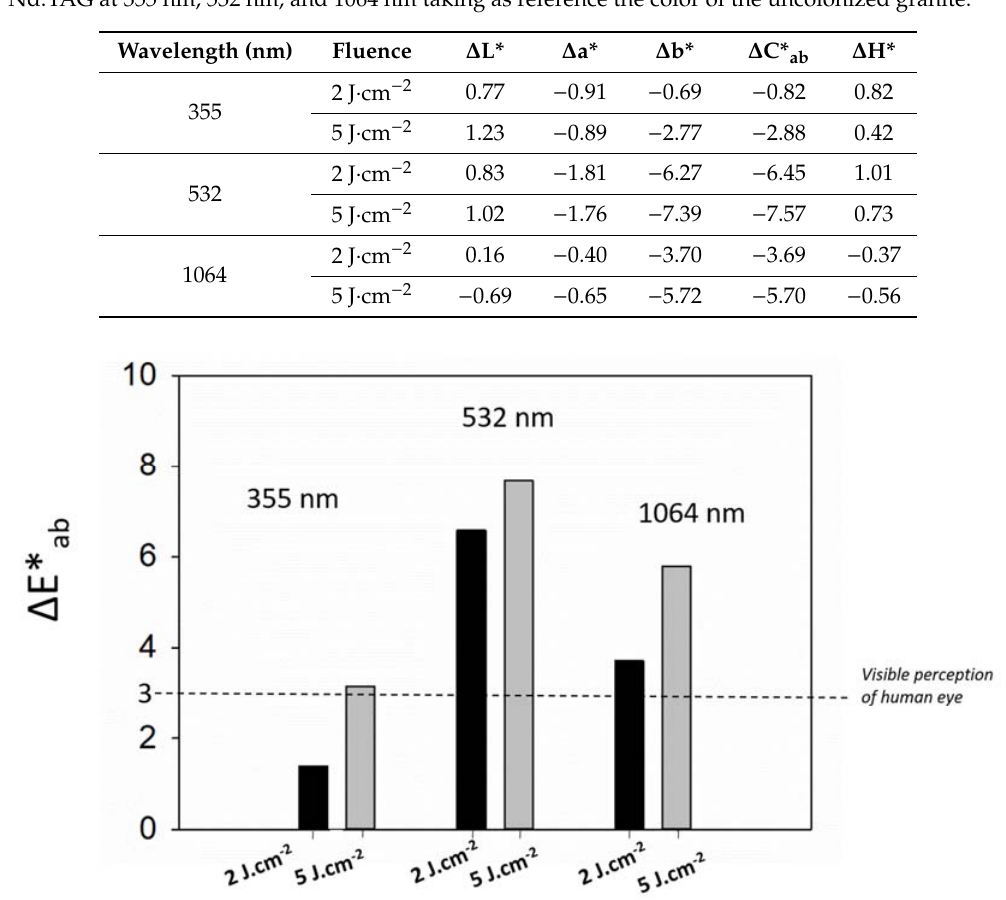
Table 2. Colorimetric di ff erences ( ∆ L*, ∆ a*, ∆ b*, ∆ C* ab , and ∆ H*) of the surfaces cleaned with laser Nd:YAG at 355 nm, 532 nm, and 1064 nm taking as reference the color of the uncolonized granite.